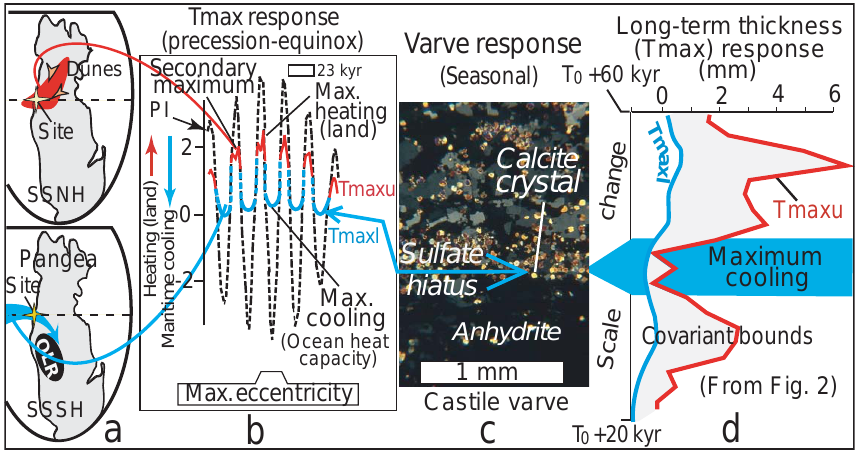
Fig. 5. Conceptual model for rectified response of varve thickness ( T max ) (a) (below) Pangea and maritime monsoon (blue arrow), which moved inland over equator near summer solstice in SH. (Above) area near Pangean equator (red) heated directly by radiation with heat directed to equator by dry northeasterly winds. Heating at equinoxes gives 8–9 month hot season. (b) Response of surface temperature at equator to global insolation as depicted in a Precession Index (dashed black). Red line is maximum linear seasonal response to insolation in red area. Secondary maxima are from heat added by rectifying surface temperature at equinoxes. Solid blue line represents monsoon (ocean) cooling effect on surface temperature. Covariant lower bound ( T maxl , solid blue trace) represents limited capacity of ocean cooling to completely cancel effect of heating during cool years. (c) Petrographic microscope photo of thin-section of Castile varve couplet (crossed nicols). Anhydrite (black-gray matrix) is hot-dry season. Sharp contact of calcite crystals (bright, yellow-brown rhombs) mark onset of cool monsoon season and sulfate hiatus. (d) 40-kyr segment of Castile series showing effect of the seasonal sulfate hiatus in the continuum of variability as cycles having wavelengths of precession and semi-precession. Note: Maximum cooling – (d) , red trace – from heating in SH is applied from the amplified upper bound of the thickness series, whereas maximum cooling in (b) (blue trace) is applied from the clipped lower bound or “cool side” of the PI. Cooling (varve thinning) applied from upper bound is not a contradiction because seasonal heating and cooling, with reference to the PI, is timed by solstices in opposing